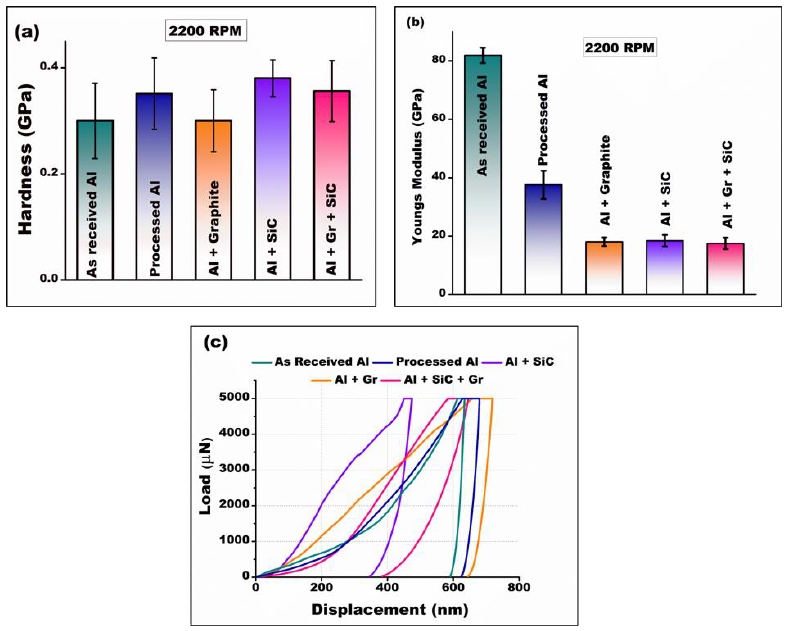
Figure 9 . Comparison of ( a ) nano-hardness, ( b ) Young’s modulus, ( c ) load vs. displacement curve at 2200 rpm. Graphite is abbreviated as Gr.